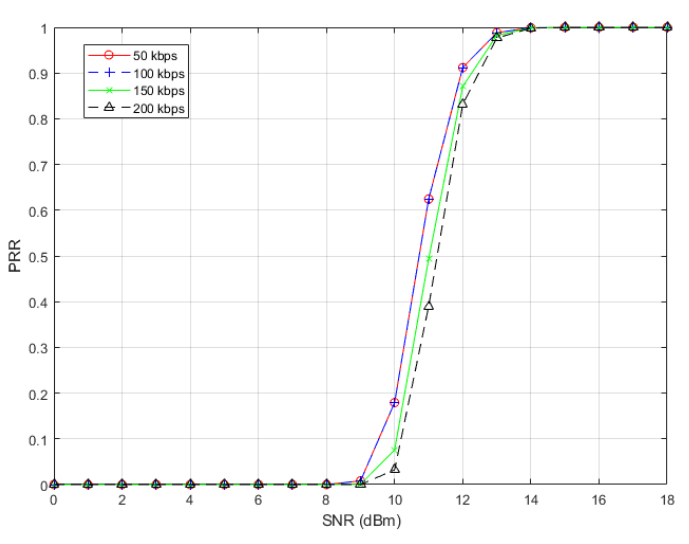
Figure 6. PRR of the 2FSK Wi-SUN channel with data rates of 50, 100, 150 and 200 kbps, respectively.